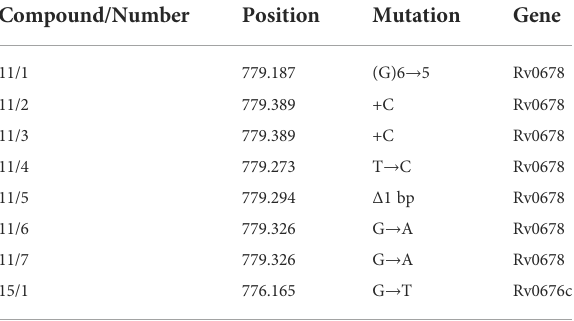
TABLE 3 The mutations identi fi ed in mmpR5 ( rv0678 ) and mmpL5 ( rv0676c ) genes of mutants resistant to compounds 11 and